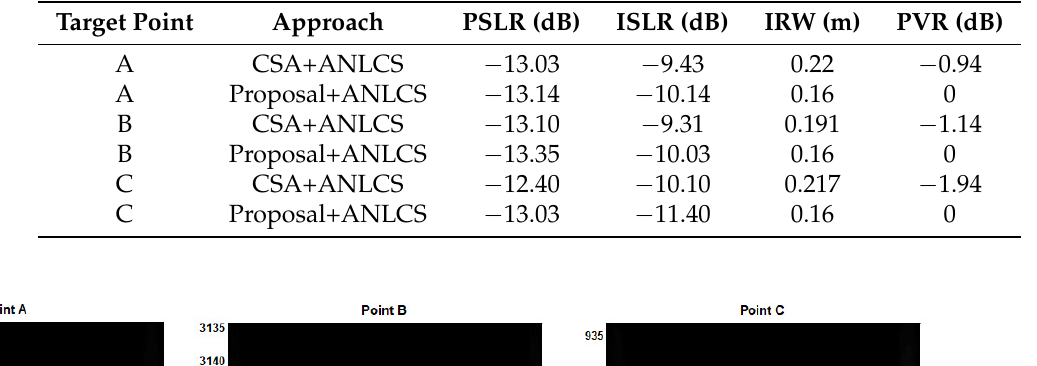
Table 2. Focus performance comparsions.